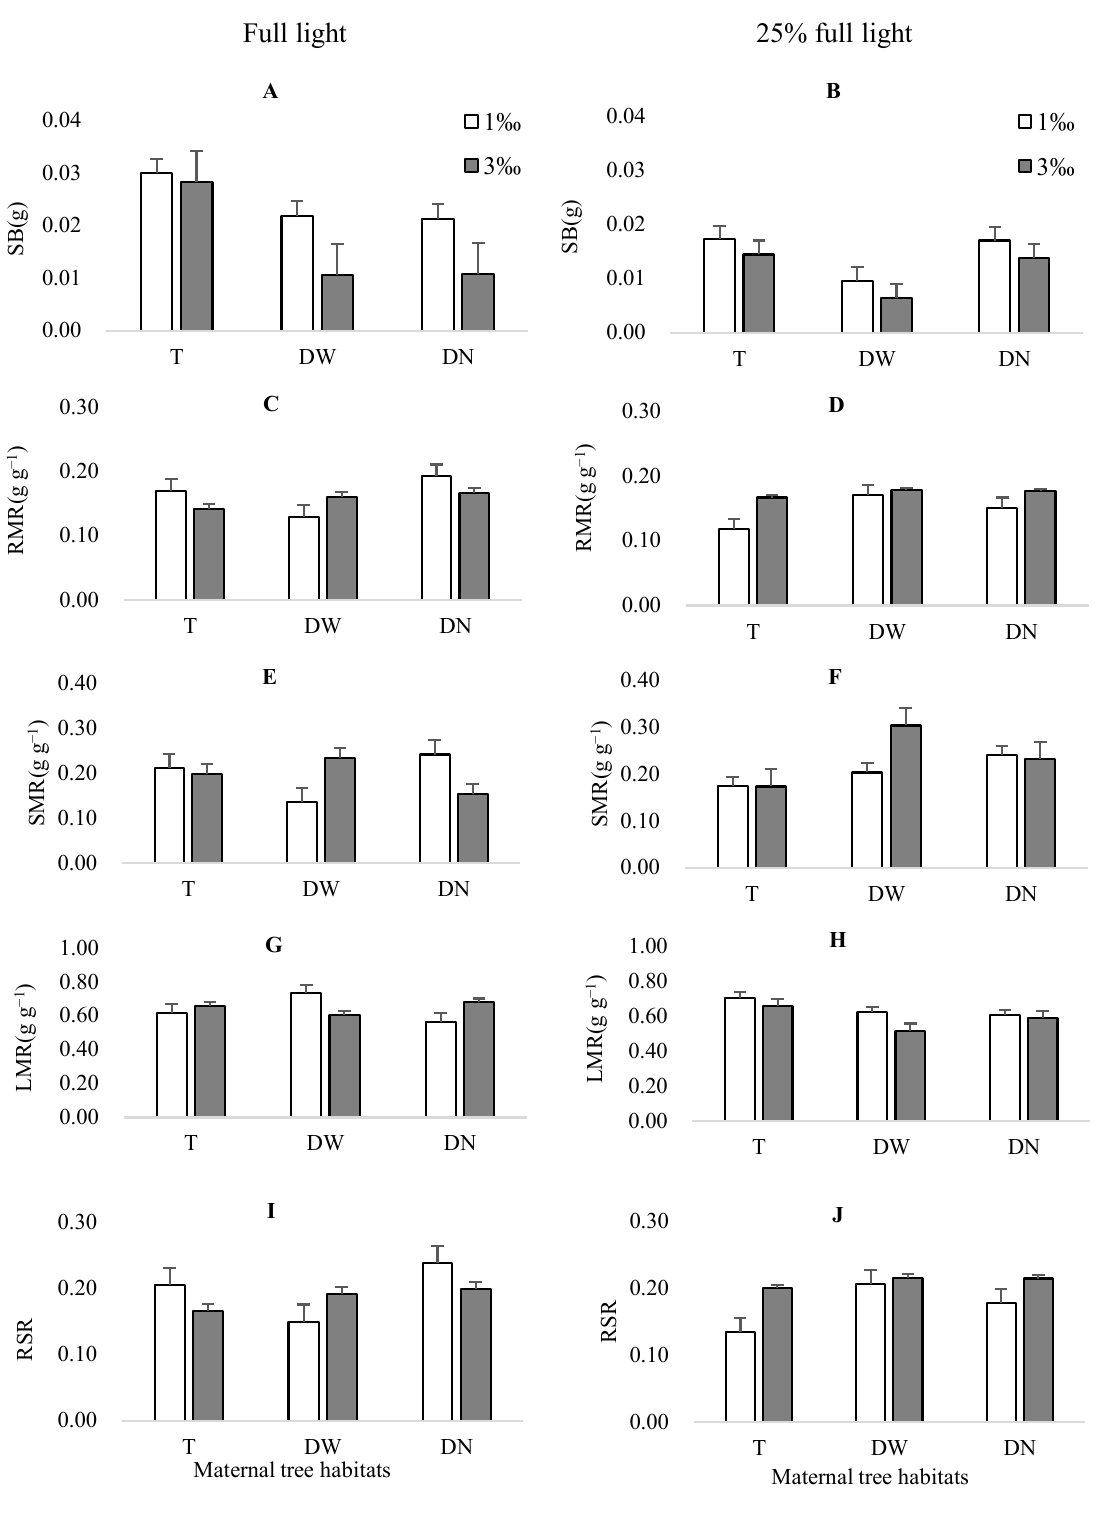
Figure 5. Effects of light intensity and salinity on biomass indices of Morus alba seedlings from different maternal tree habitats. T: seeds from nonsaline soil; DW: seeds from Jiufenchang in saline– alkali land; DN: seeds from Shenxiangou in saline–alkali land. ( A ): SB, full light; ( B ): SB, 25% full light; ( C ): RMR, full light; ( D ): RMR, 25% full light; ( E ): SMR, full light; ( F ): SMR, 25% full light; ( G ): LMR, full light; ( H ): LMR, 25% full light; ( I ): RSR, full light; ( J ): RSR, 25% full light.